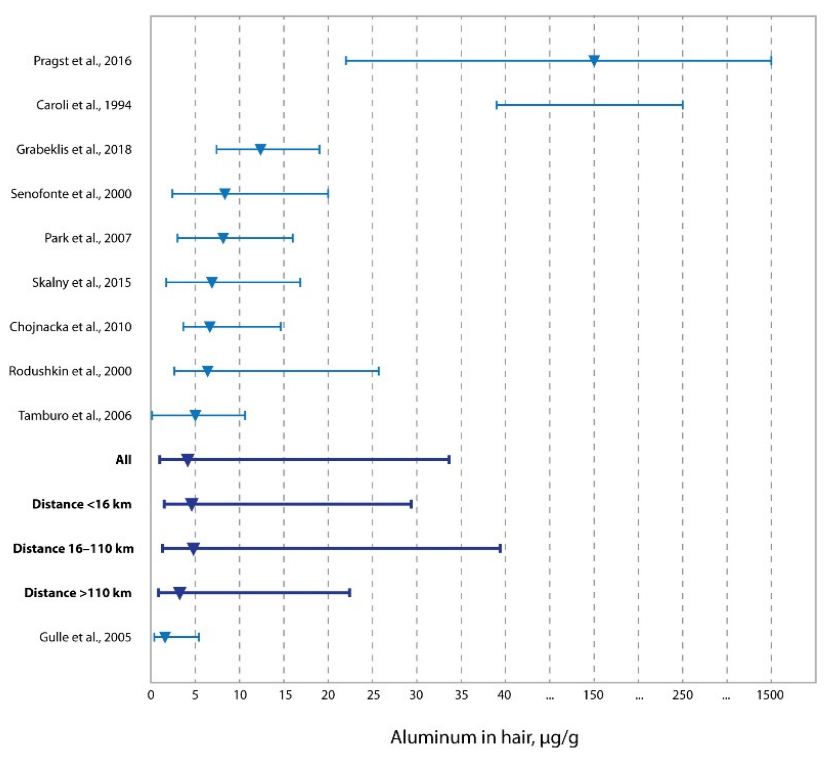
Figure 3. Concentrations of aluminum in the hair of residents living at different distances from oil and gas production fields vs. literature data (medians and ranges) [13,48–50,52,54–58].